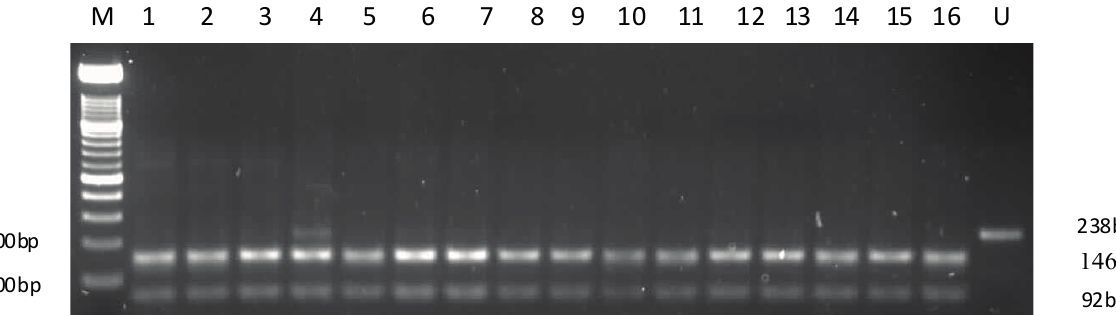
Figure 1. A representative 2% agarose gel of restriction digestion products with MspI for − 482 of APOC3 promoter region genotyping. The expected size of amplified product was 238 bp. Restriction patterns obtained with MspI were as follows: Lane M: 100 bp molecular marker; Lanes 1–3 and 5–16, wild type − 482 CC genotype; Lane 4, CT, heterozygous genotype; and Lane U: undigested sample (no enzyme added). The presence of a restriction site is indicated by two or three bands.